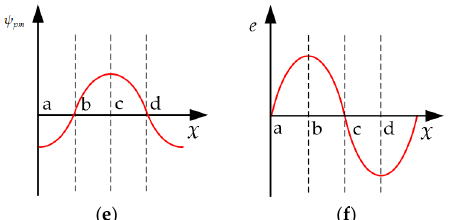
Figure 4. Working principle of the A phase: ( a ) The secondary position a; ( b ) The secondary position b; ( c ) The secondary position c; ( d ) The secondary position d; ( e ) The flux linkage; and, ( f ) The back-EMF.